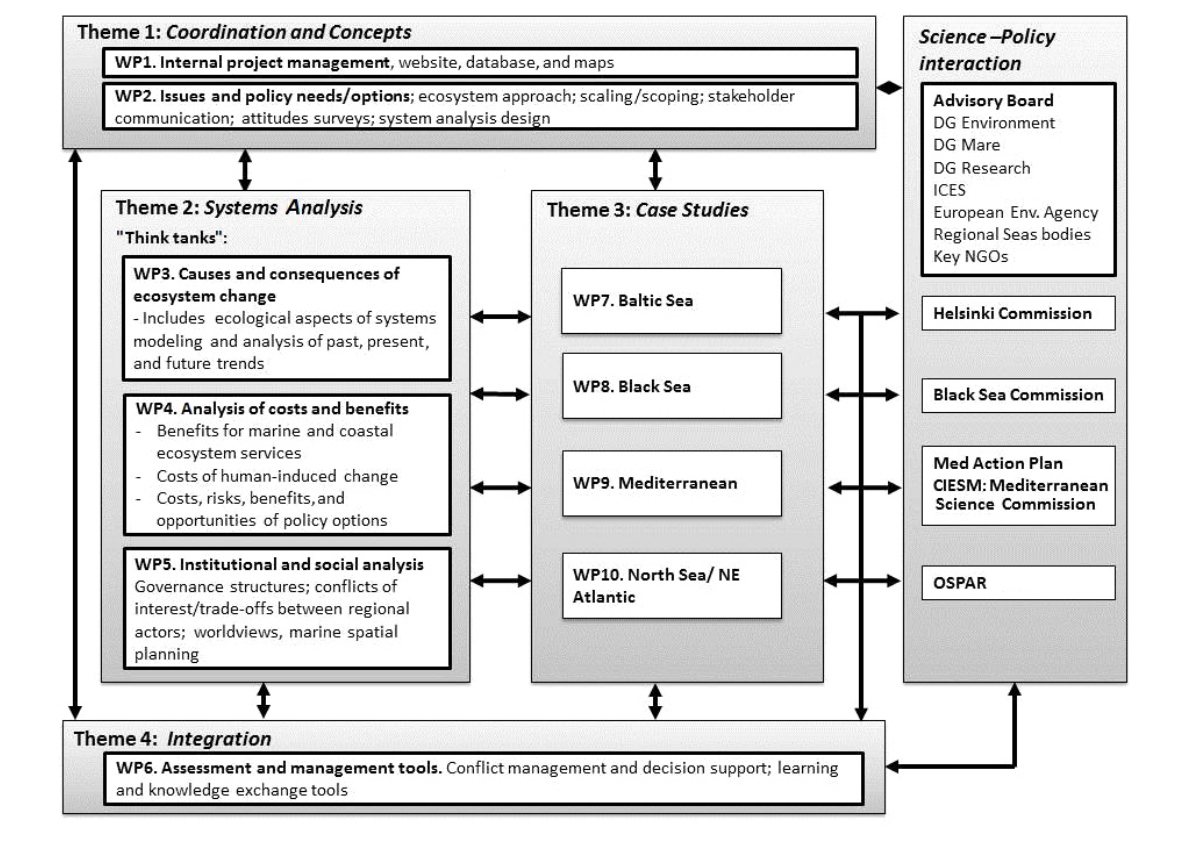
Fig. 2 . Structure of the KnowSeas project, using a systems approach for research on coupled social-ecological systems in Europe’s seas (WP = Work Package; DG = Directorate General [in the European Commission]; ICES = International Council for the Exploration of the Sea; OSPAR = OSPAR Commission on the NE